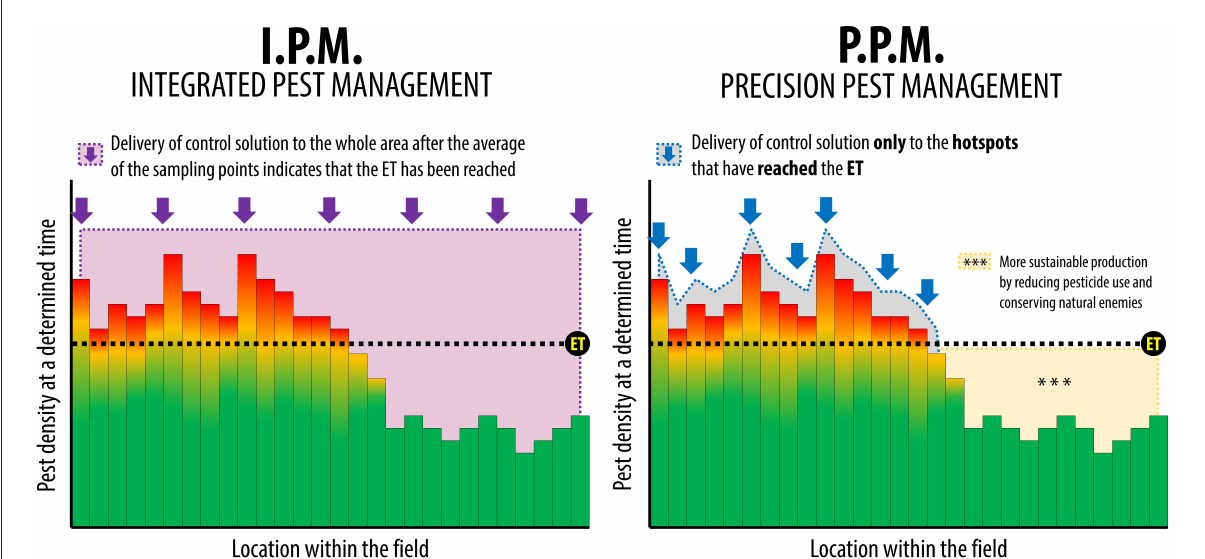
FIGURE1 Digital transformation in agriculture, leading to precision pest management (PPM), with the use of digital tools to monitor the fields and identify the regions (hotspots) where pest populations have reached the economic threshold (ET), and the delivery of control solutions only to the hotspots, instead of delivery to the whole area, as in integrated pest management (IPM). Adapted from Molin et al.